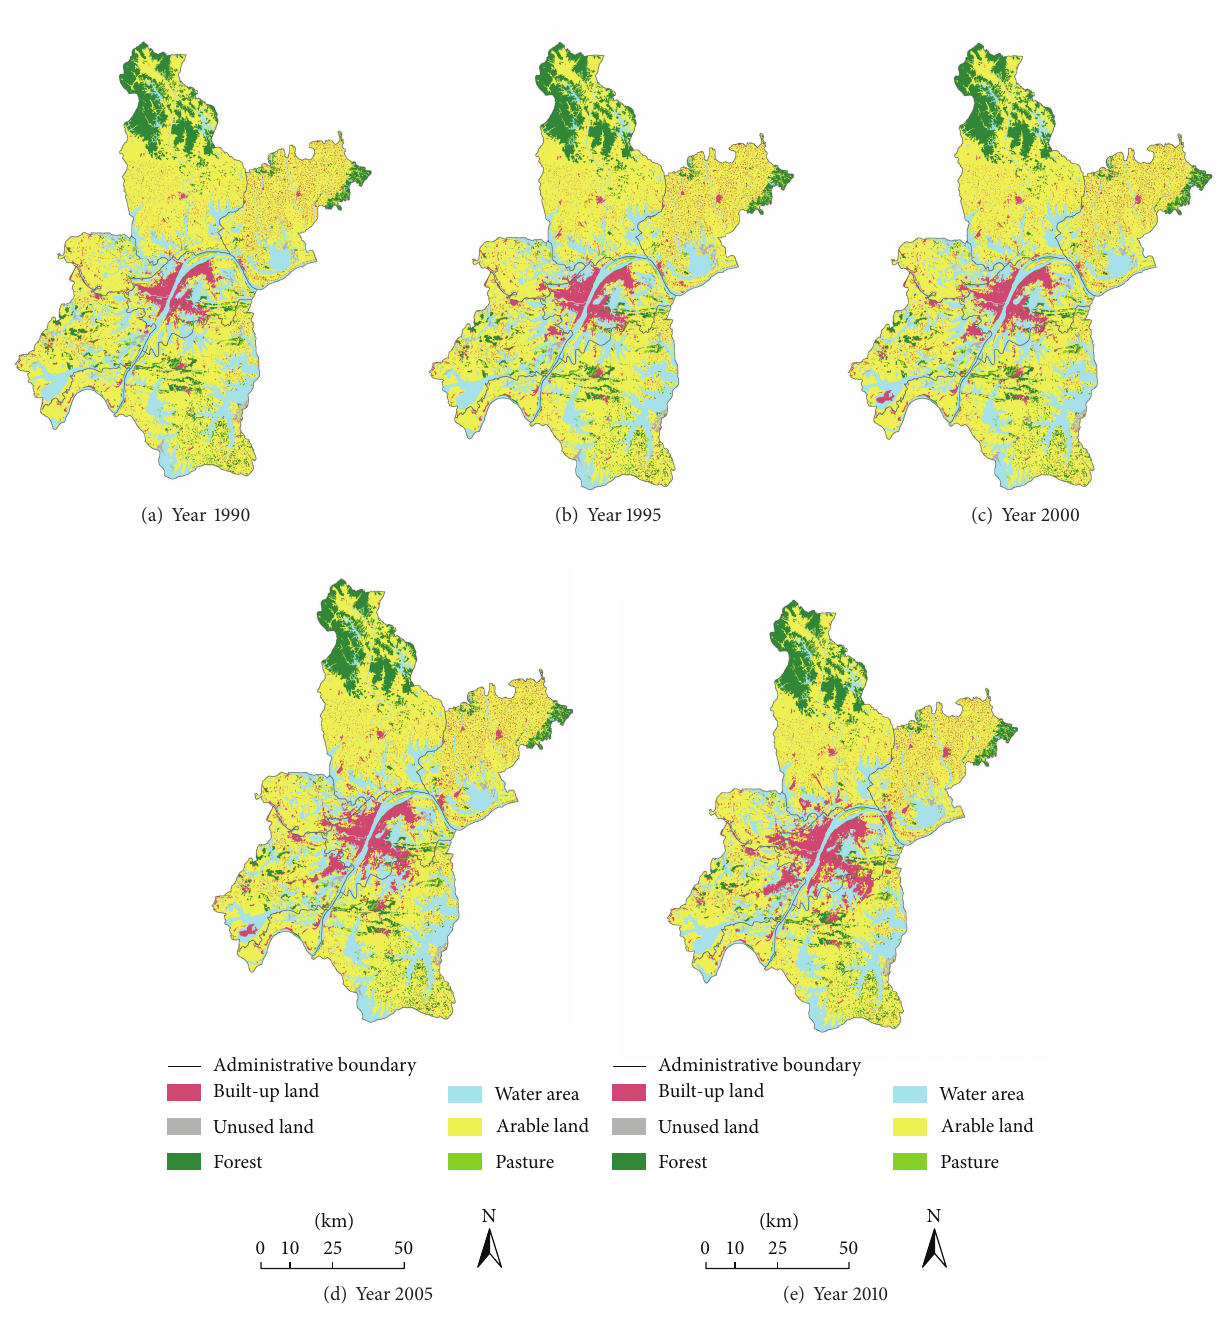
Figure 2: LULC maps of 1990, 1995, 2000, 2005, and 2010 in the Wuhan